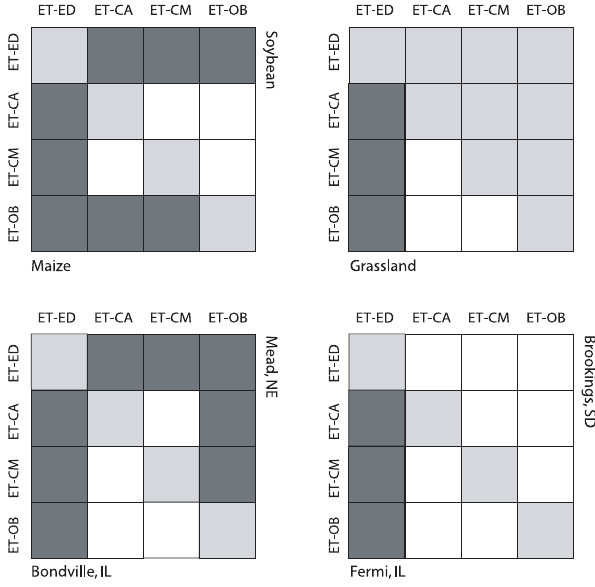
Fig. 4. Diagram of differences between DORs revealed by Kolmogorov-Smirnov tests. In the top row DORs grouped by veg- etation type; bottom row – by location. Dark grey color indicates significant difference with p value < 0.01 between compared distri- butions; white is no significant difference between DORs; light grey is no comparison made. ET-ED is the ET obtained through VegET parameterized by K cp from EDPM; ET-CA is the ET derived via VegET driven by K cp from AVHRR based climatologies; ET- CM is the ET derived via VegET driven by K cp from MODIS based long term averages; ET-OB is the ET derived via VegET driven by K cp transformed from retrospective MODIS time